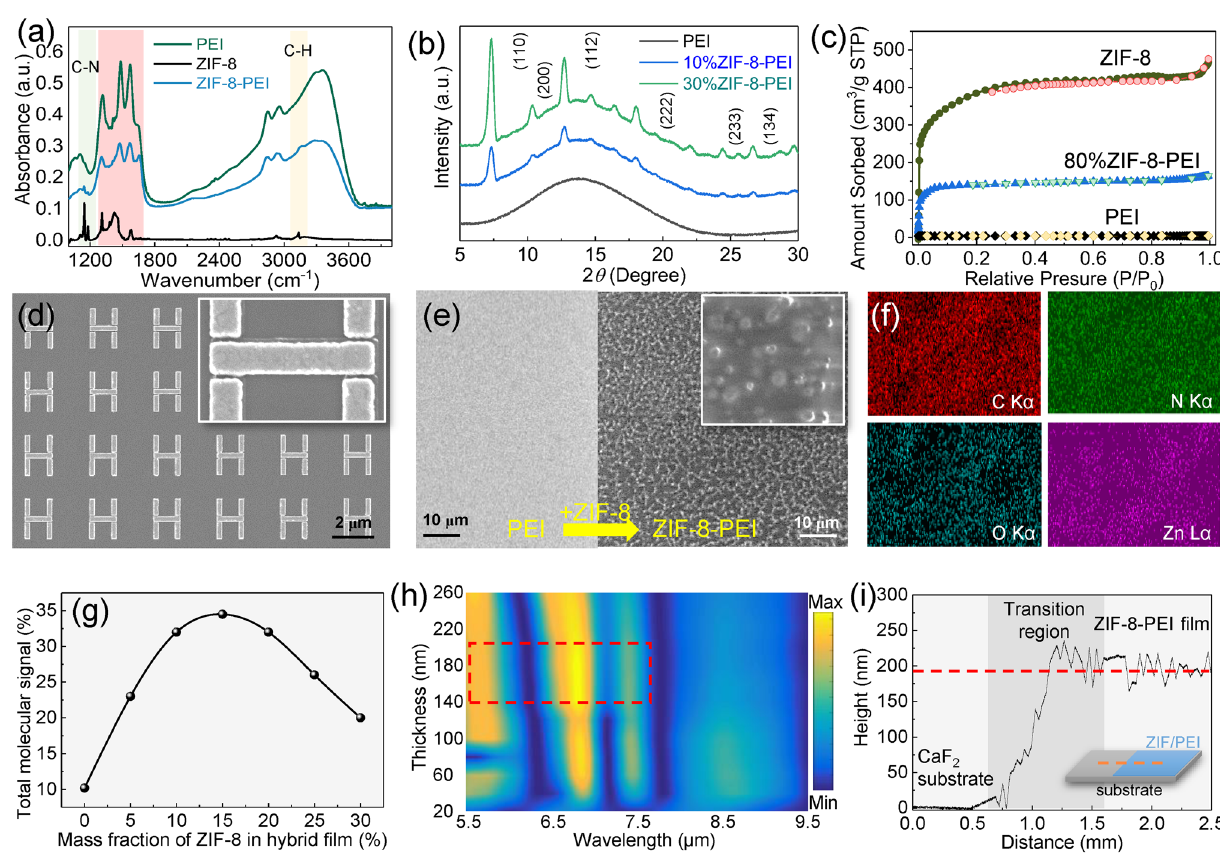
Fig. 5 Material characterization. a IR absorbance spectra of PEI, ZIF-8, and ZIF-8-PEI. b XRD spectra of PEI, 10% ZIF-8-PEI, and 30% ZIF- 8-PEI showing their phase details. c N 2 adsorption–desorption isotherms for PEI, ZIF-8, and ZIF-8-PEI at 77 k showing their BET surface area. d SEM micrograph showing the details of our multi-hotspot nanoantennas. e SEM images showing the nanoantennas with PEI film (left panel) and ZIF-8-PEI hybrid film (right panel). f EDX mapping analysis of the ZIF-8-PEI hybrid film. g Profile curve of enhanced molecular signals versus ZIF-8 mass fraction showing the influence of ZIF-8 mass fraction on enhanced signals. h Hybrid film thickness versus spectrum wave- length map revealing the effect of film thickness on enhanced molecular signals of our multi-hotspot nanoantennas. i Thickness measurement of ZIF-8-PEI hybrid film using a